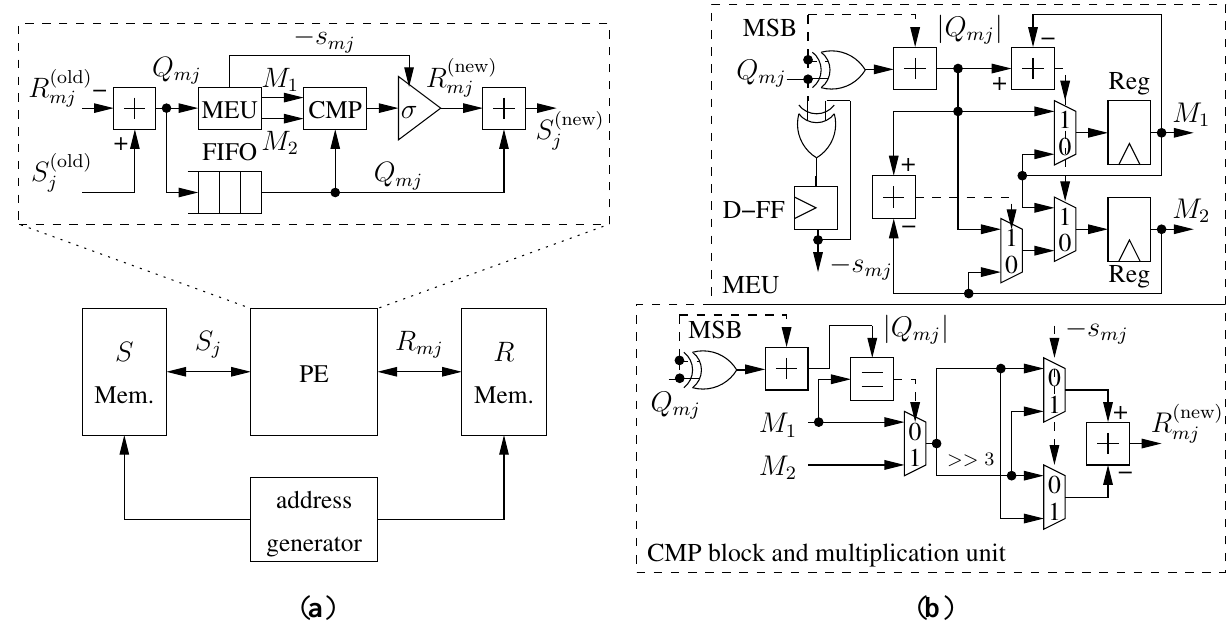
Figure 5. Proposed decoder architecture: ( a ) general structure and PE detail; ( b ) MEU, CMP block and multiplication unit block schemes.